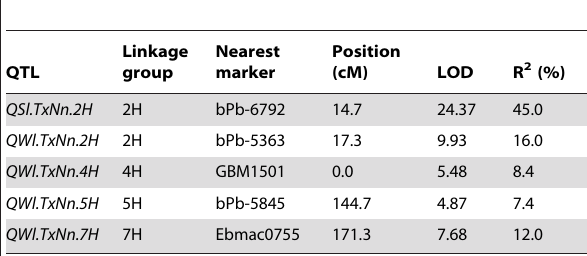
Table 2. QTL for salinity and waterlogging tolerance identified in the DH population of TX9425 6 Naso